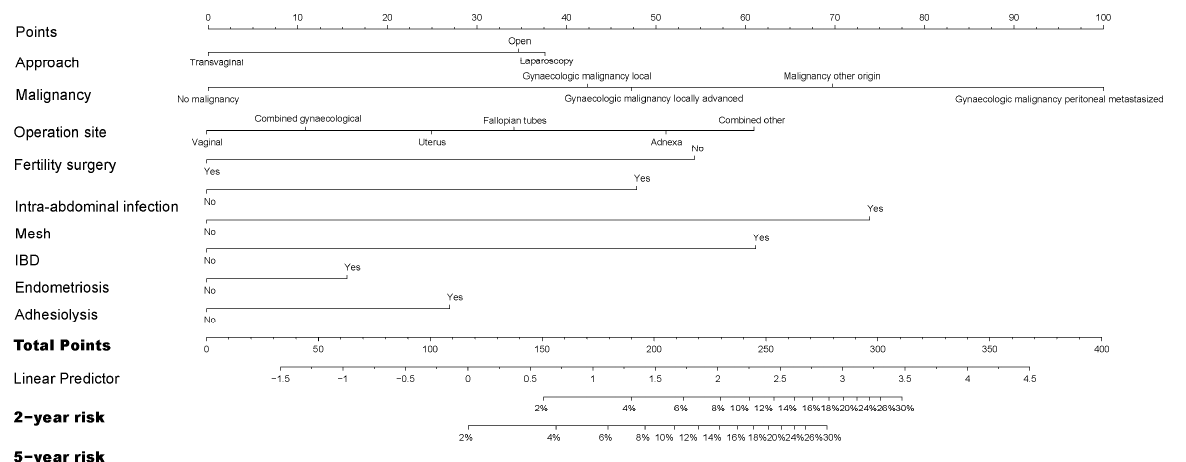
Figure 2. Nomogram to predict readmission directly related to adhesions in women who underwent gynecological surgery. By drawing a vertical line from each variable to the points axis on top and summing the individual points for all variables, the total score is calculated. From the total score axis perpendicular to the bottom, the linear predictor and the 2- and 5-year risk for reoperation are determined. IBD = inflammatory bowel disease.